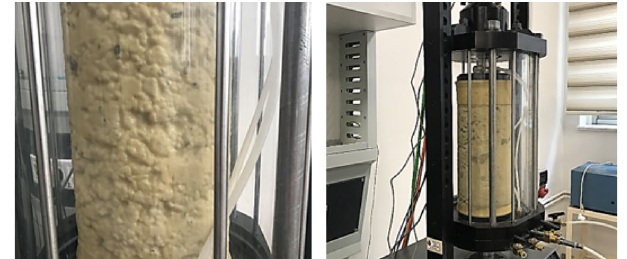
Figure 4. The preparation of samples for the resilient modulus test.